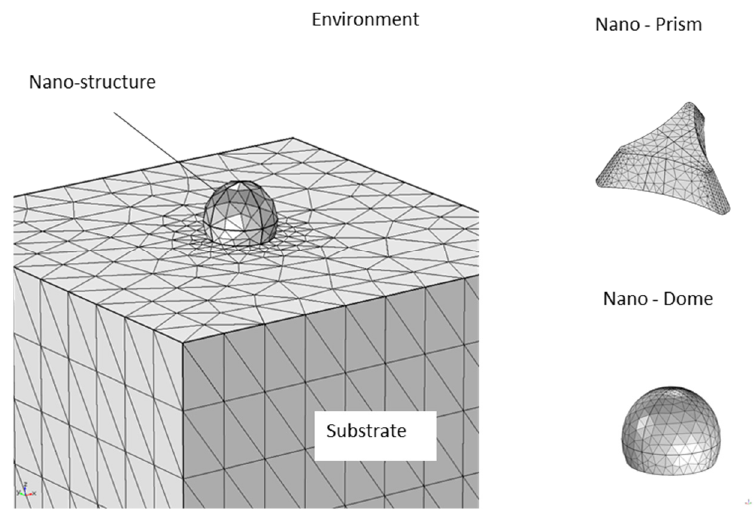
Figure 2. Schematic illustration of the geometry and the mesh elements distribution used for the simulation of Au nano-prism and nano-domes.